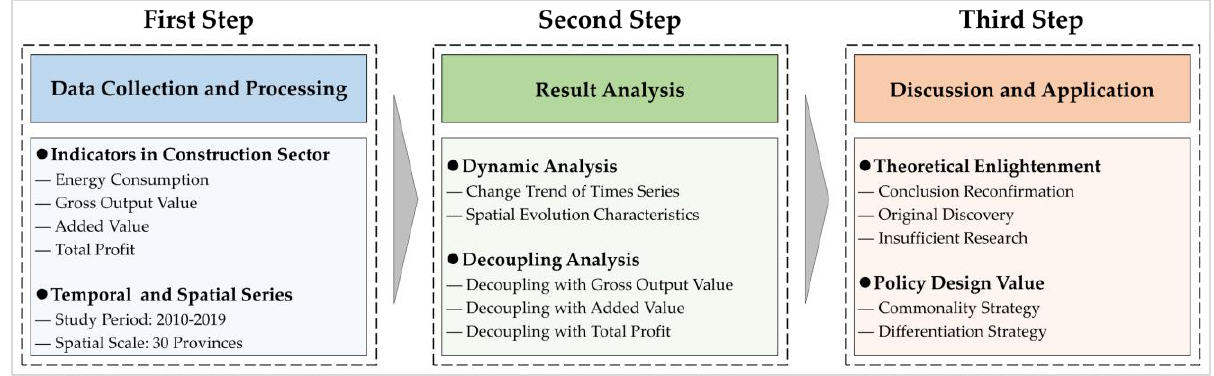
Figure 4. Research